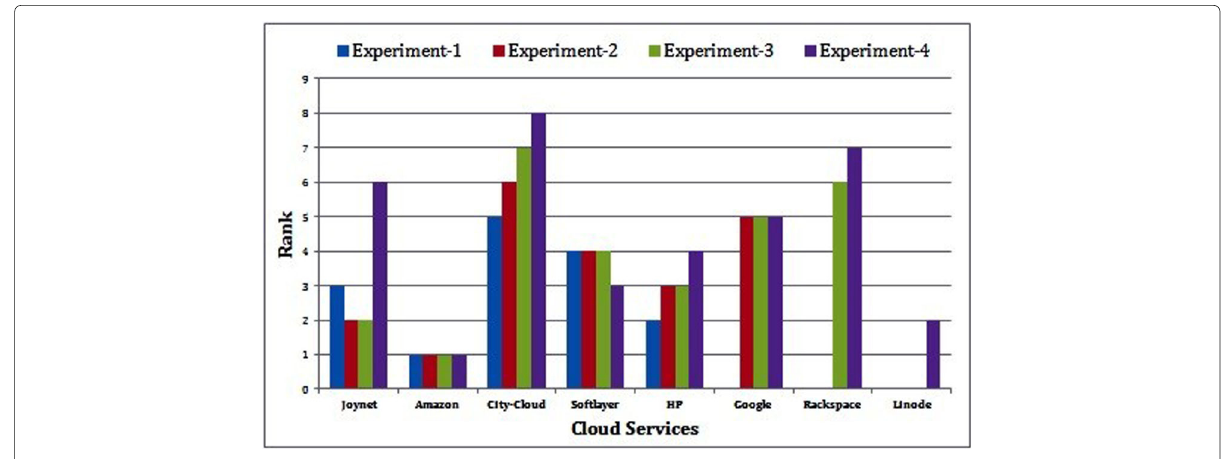
Fig. 3 Rank for Case Scenario 2